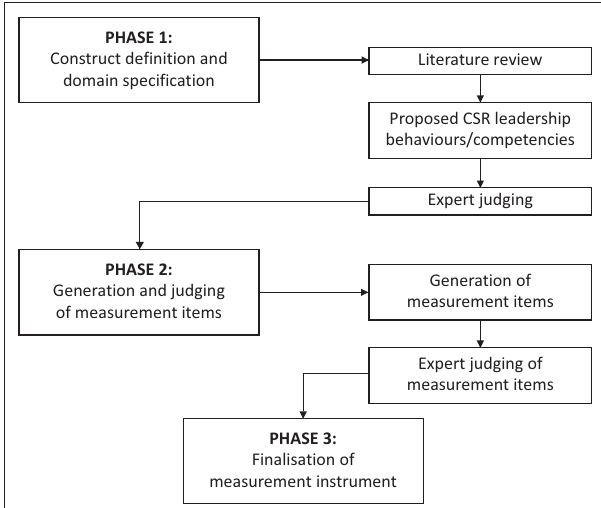
FIGURE 1: Corporate social responsibility leadership questionnaire (CSR-LQ) development process prior to empirical